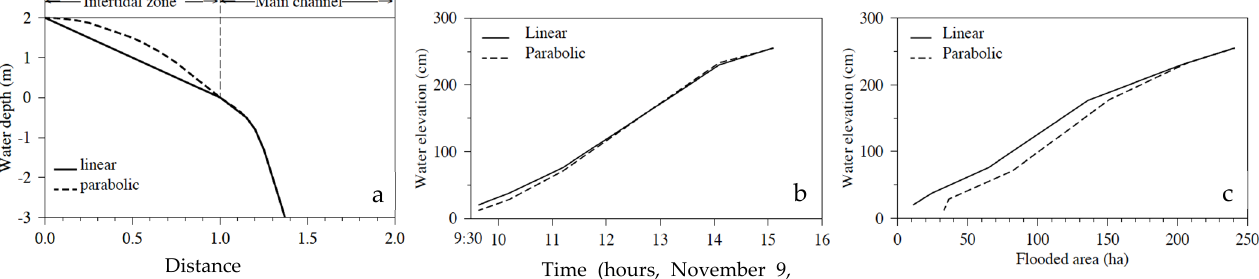
Figure 12. Water elevations and flooded areas on 9 November 2001 predicted by the OCRE-FVCOM for the cases with linear and parabolic distributions of the bottom slope over the intertidal saltmarsh zone. ( a ) A schematic figure showing the slope. ( b ) The averaged water level over the hypsometric measurement areas. ( c ) The flooded area calculated based on the hypsometric measurement covered areas.